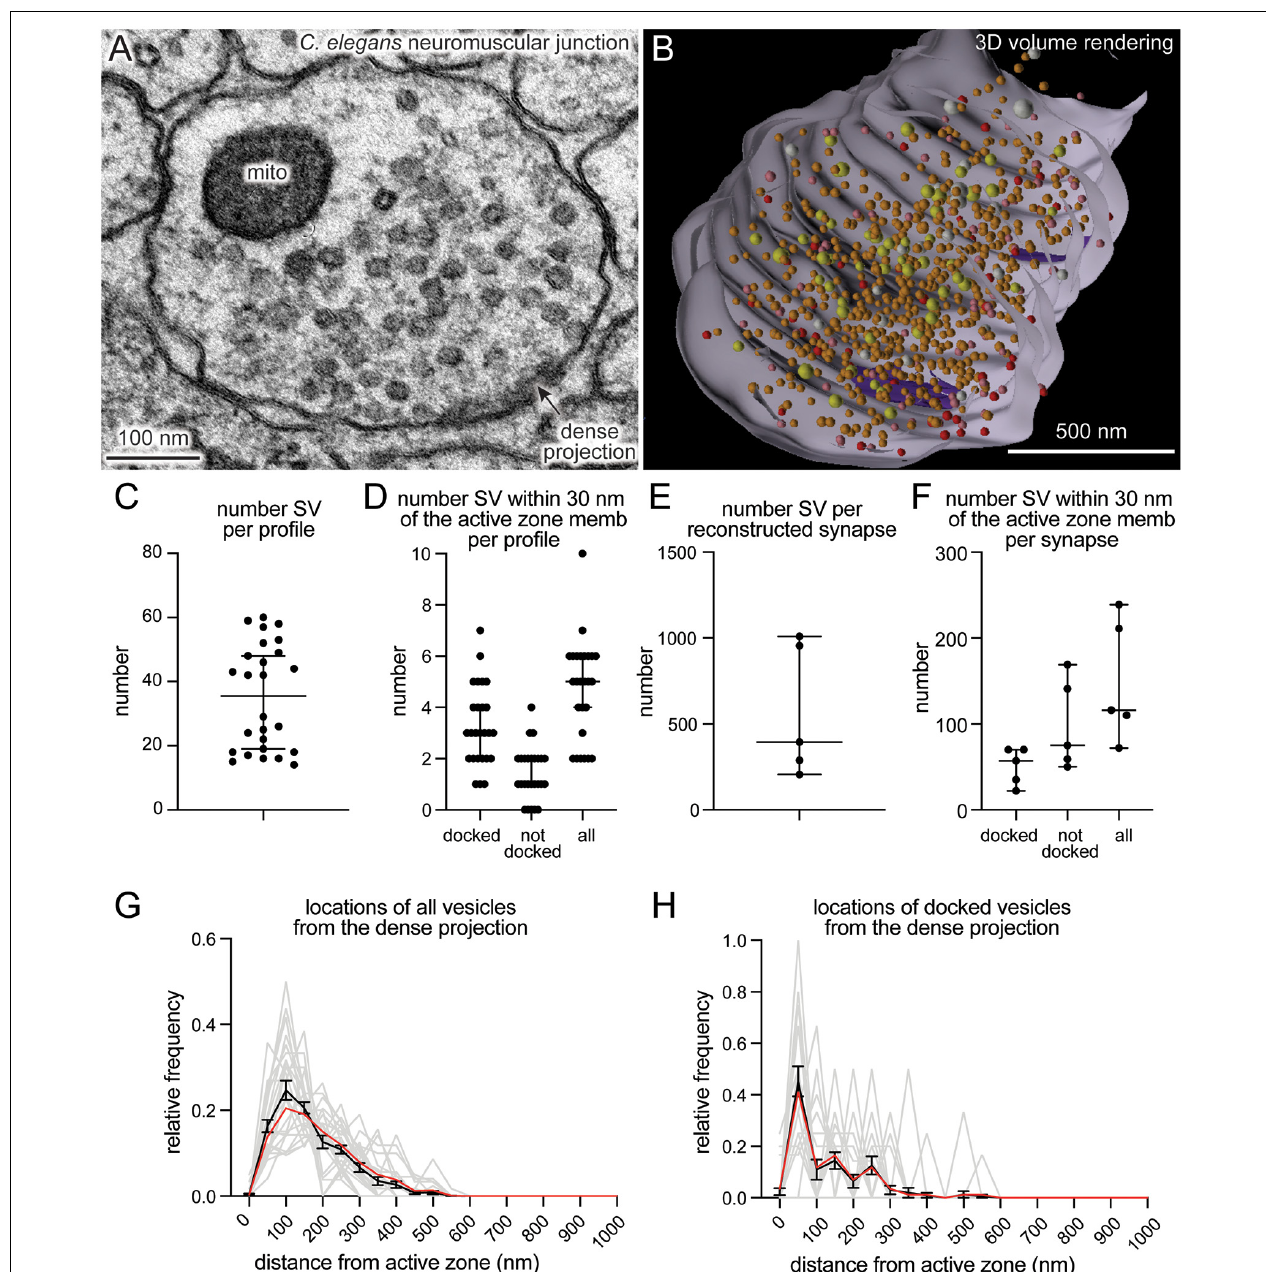
FIGURE 4 | SynapsEM works with other model systems and with 3D reconstruction programs. (A) An example micrograph from a serial reconstruction of a C. elegans neuromuscular junction, shown in (B) . Fourty-eight raw electron micrographs (33 nm each) in series are segmented in Fiji, and x,y-coordinates of each structure exported into text files (i.e., x,y-coordinates from the contour of endosomes, dense projections, plasma membrane). Using x,y-coordinates, polygonal meshes on membranes and dense projections are created using the “loft” command, and vesicles created using the “sphere” command in Maya (see Supplementary Information ). The z-coordinates for all structures in each slice were determined based on the slice number and increments of 33 nm. (B) A snap-shot of the reconstructed synapse using Maya, based on the x,y-coordinates collected from each profile in this study. Red = docked synaptic vesicles; Orange = synaptic vesicles; yellow = dense-core vesicles; white = large vesicles; purple = dense projections. (C) A plot showing the number of vesicles in single synaptic profiles. Each dot = the number in a profile. (D) A plot showing the number of vesicles within 30 nm of the active zone membrane per profile, and the number of those vesicles docked or tethered at the active zone. Each dot = the number in each profile. (E) The total number of synaptic vesicles from synapses fully reconstructed from serial electron micrographs. (F) the number of vesicles within 30 nm of the active zone membrane per profile and the number of those vesicles docked or tethered at the active zone from fully reconstructed synapses. (G) A plot showing the distribution of synaptic vesicle distances to the dense projection. (H) A plot showing the distribution of docked synaptic vesicle distances to the dense projection. In (G,H) , gray lines = the normalized distribution from each profile. Black line = average from 26 profiles. Red line = the normalized abundance from the pooled data.